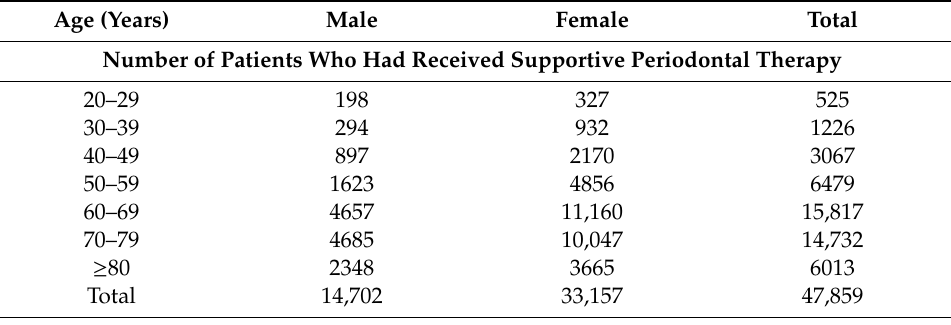
Table 1. Characteristics of the study population.